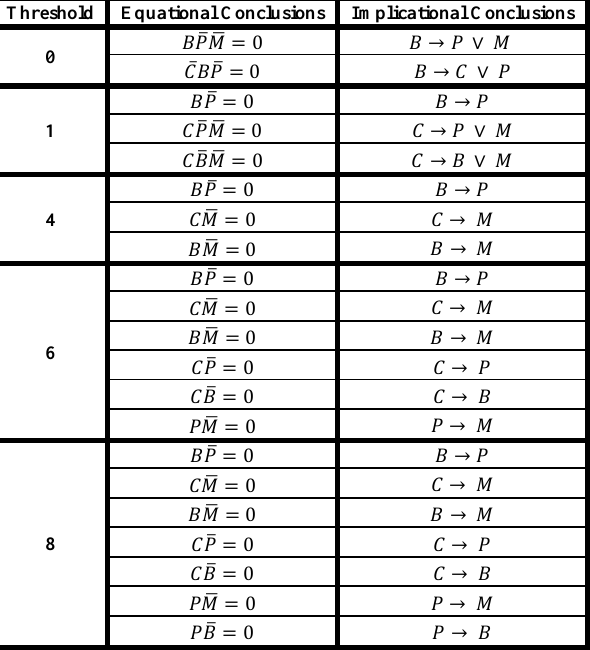
Table 3. Conclusions of Boolean Analysis for various plausible thresholds Threshold Equational Conclusions Implicational Conclusions